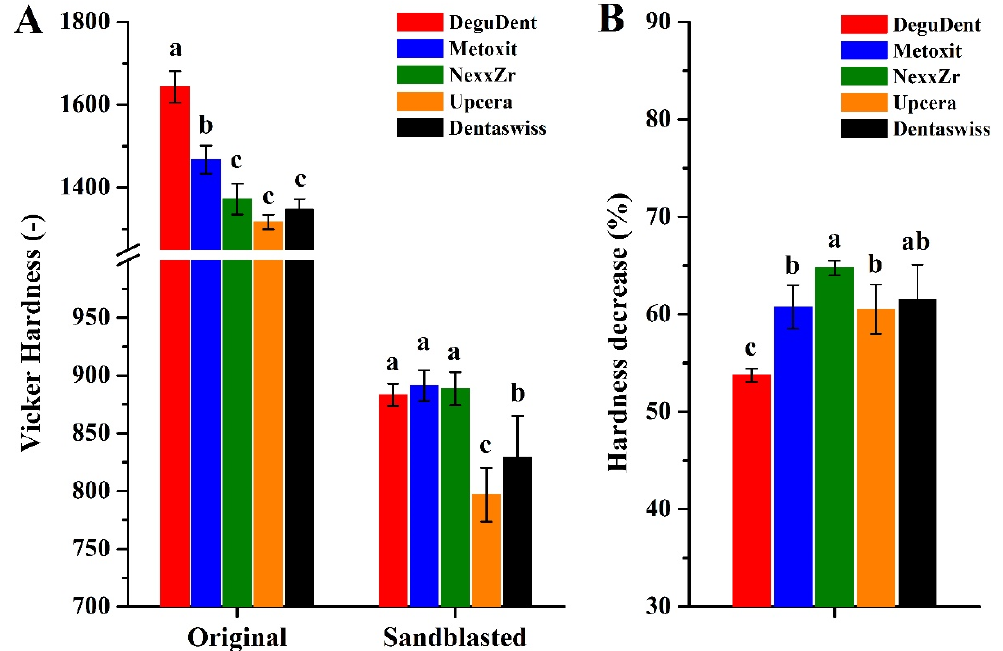
Figure 4. The surface microhardness of zirconia samples of different brands: ( A ) Sample before and after sandblasting; ( B ) Sandblasting compares the drop of samples. Means with different letters were significantly different ( p < 0.05, mean ± SD, n = 4).